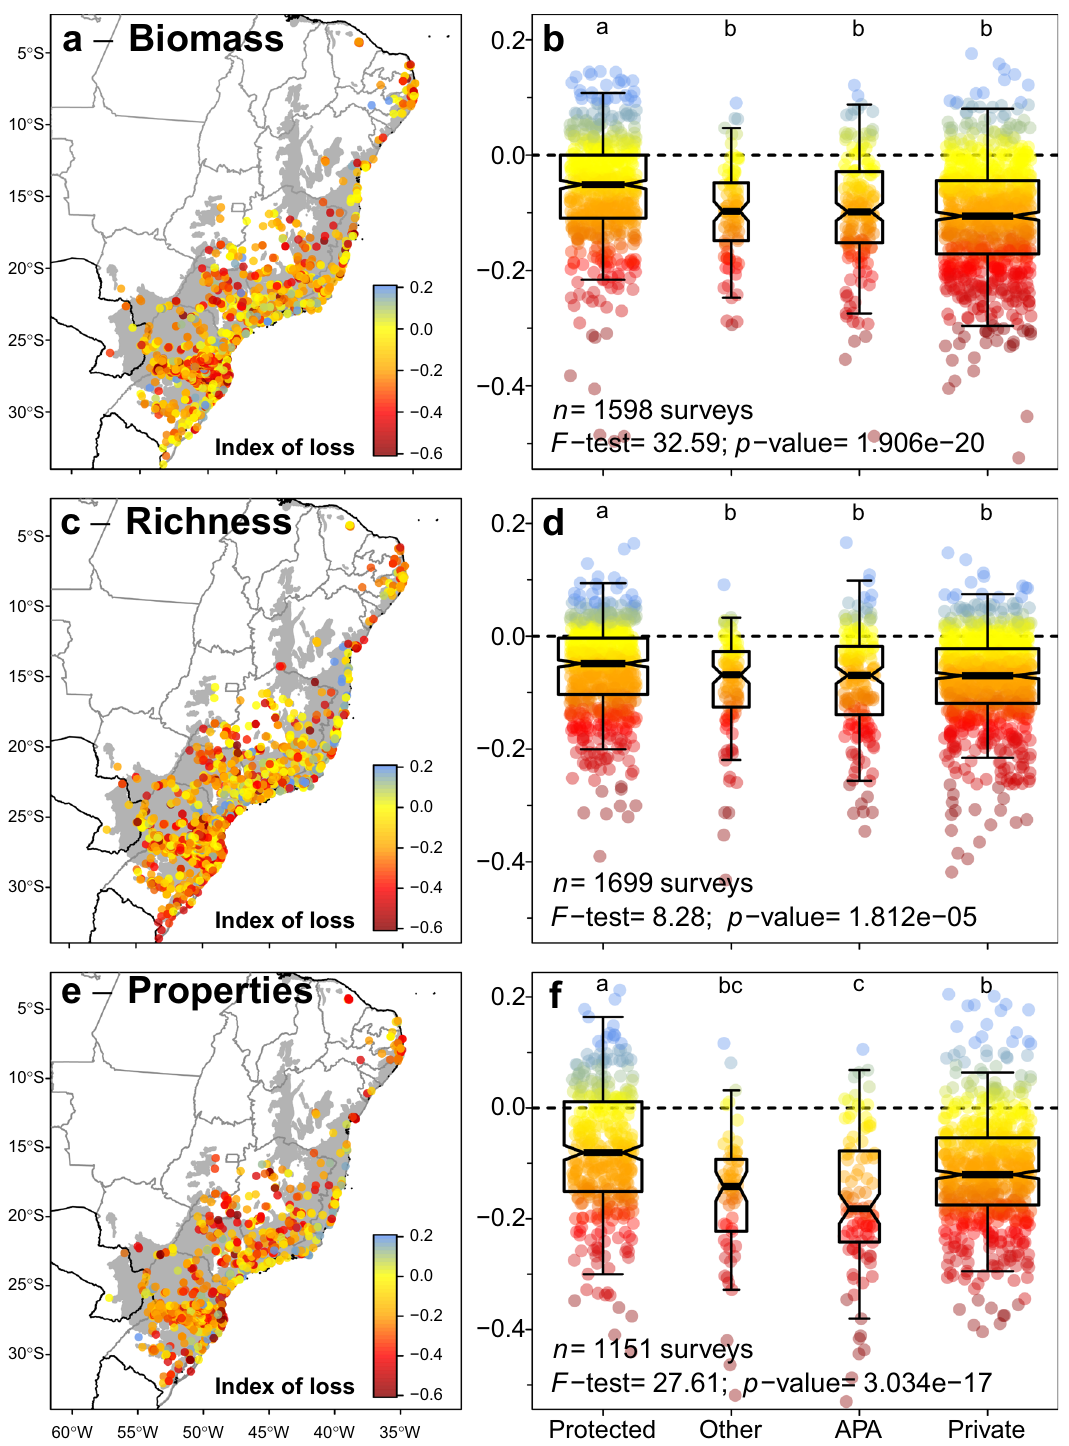
Fig. 4 The distribution of the indices of loss across the Atlantic Forest and the effects of land conservation category. Each point represents one forest survey for which the index of loss was estimated for forest biomass ( a , b ), tree species richness ( c , d ) and species properties ( e , f ). In panels a , c , and e , the shaded area is the original extent of the Atlantic Forest. In panels, b , d , and f , the box-and-whisker diagrams summarize the distribution of the indices of loss for each land-use category (i.e. bold centre line, median; box limits, upper and lower quartiles; whiskers, 1× interquartile range), organized from left to right in decreasing order of protection. The F -statistics, the associated p -value, and the number of observations of the models are presented, as well as the result of the Tukey ’ s honest signi fi cance test (one-sided, with an adjustment for group sample sizes) for difference among group means (lowercase letters above each box-and-whisker diagram). Degrees of freedom: 1579 ( b ), 1698 ( d ), and 1150 ( f ). Legend: Protect indicates Strict protection and Sustainable Use conservation units; Other indicates other public and protected lands (e.g. research centres, university campuses, botanical gardens, military, and indigenous land); APA indicates private land inside areas with sustainable use of natural resources, locally known as “ Environmental Protection Areas ” ; Private indicates private